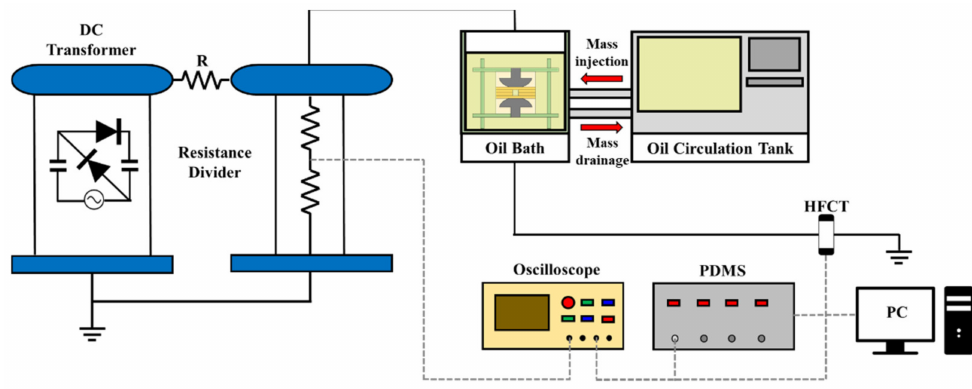
Figure 3. Block diagram of direct current (DC) partial discharge